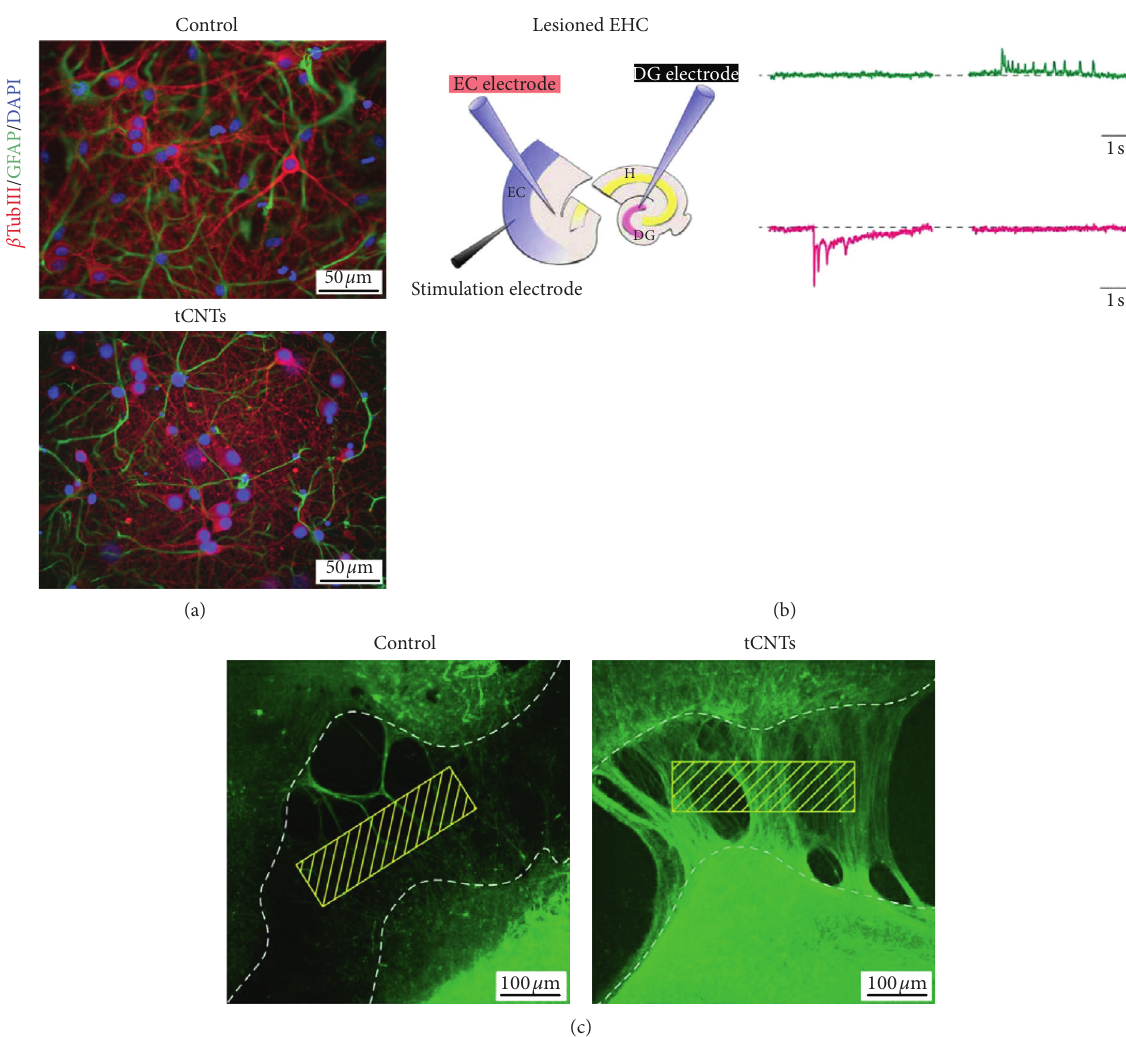
Figure 6: (a) Fluorescent micrographs of dissociated primary cells networks grown on glass control substrates (top) and on tCNTs substrates (bottom) ( β -tubulin III, red: neurons; GFAP, green: astrocytes; DAPI, blue: cell nuclei). (b) tCNTs induce the sprouting of functionally active fibers crossing lesioned areas in entorhinal-hippocampal complex organotypic cultures (EHCs). (a) Entorhinal cortex/ dentate gyrus (EC/DG) intercommunication ability through the perforant pathway (PP) transection in intact and lesioned EHC using a stimulation electrode inserted into the EC superficial layer. (c) Representative confocal images showing the sprouting of SMI32-positive axon fibers (in green) crossing the gap area